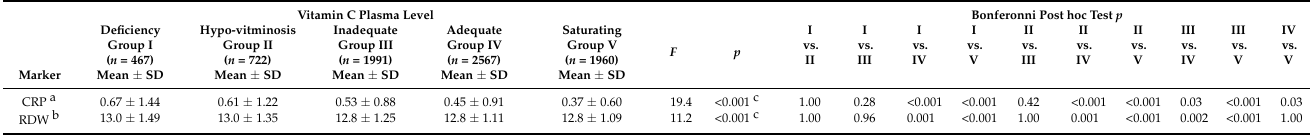
Table 2. Inflammatory markers CRP and RDW across vitamin C plasma level quintiles.